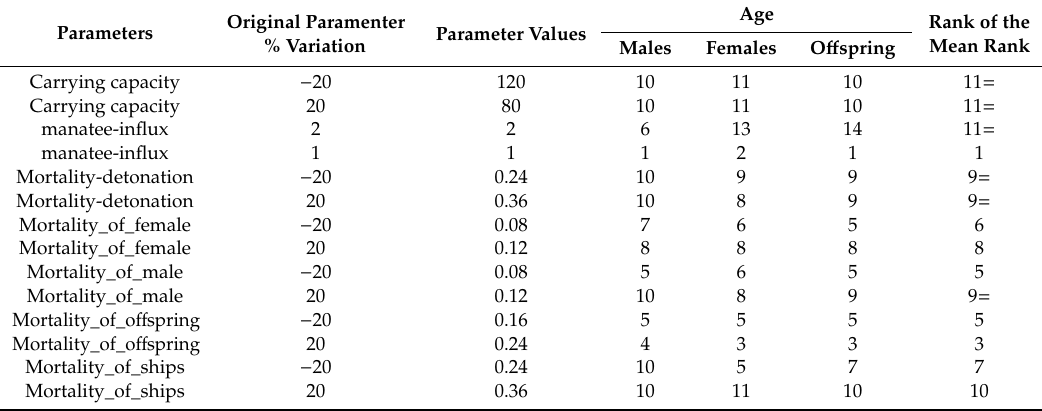
Table 2. Overall ranks of the parameters that showed sensitivity to changes on ± 20% for age per sex and life stage. Due to the nature of the manatee-influx parameter, units are the number of individuals, and changes cannot be less than zero or fractional. The “ = ” indicates a tie in